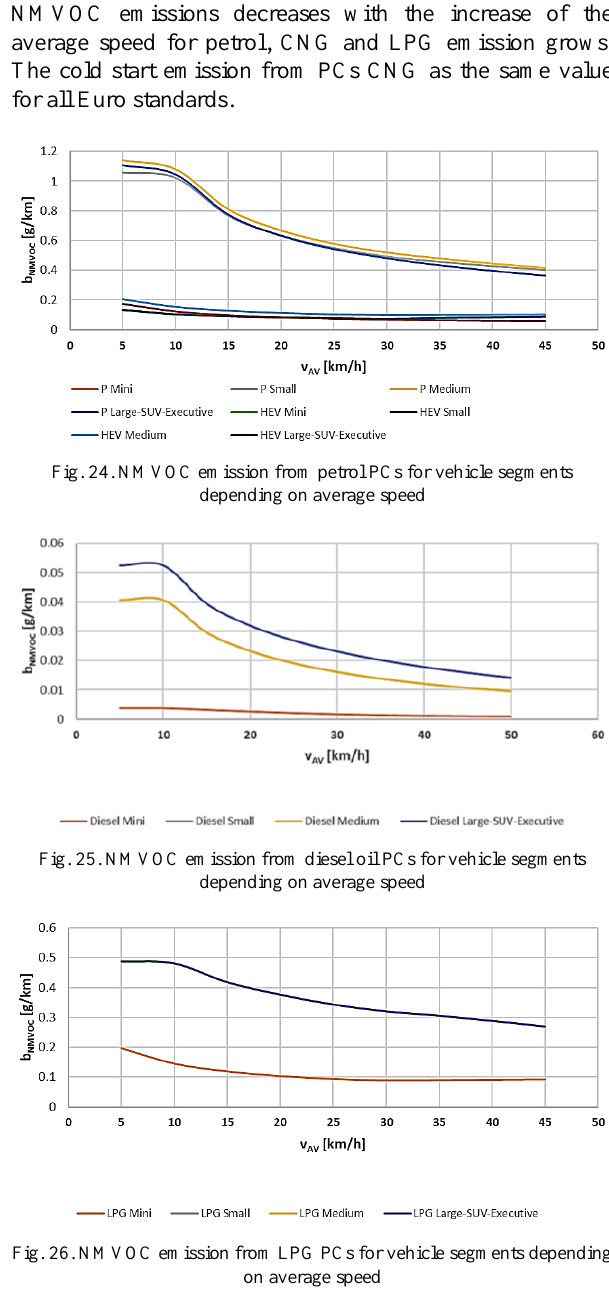
Fig. 22. NMVOC emission from LPG PCs for Euro standards depending on average speed